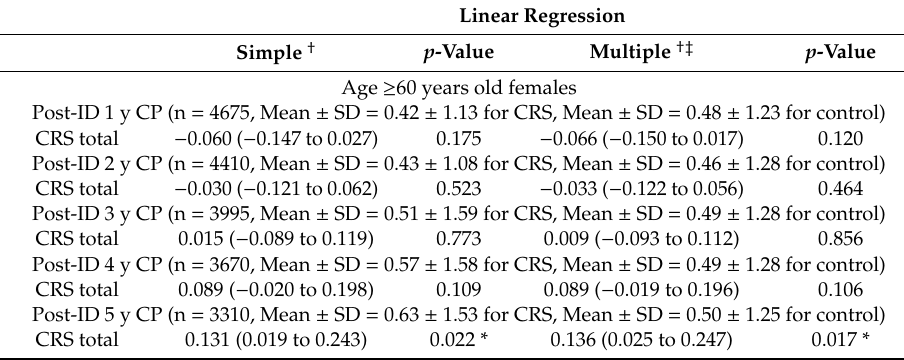
Table 3. Cont . Linear Regression